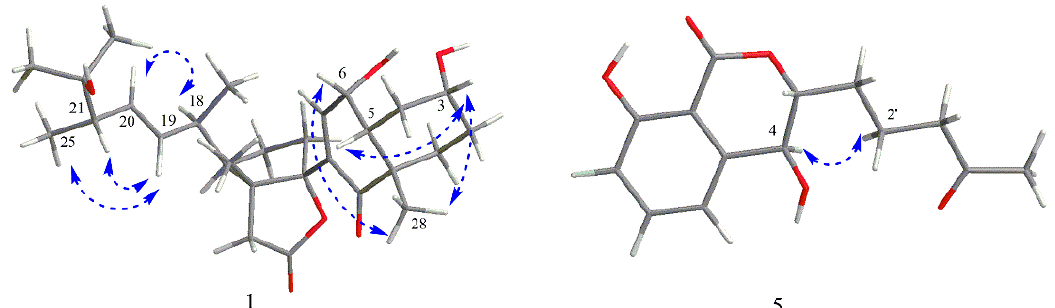
Figure 3. Key partial structures of compounds 1 and 5 from NOESY data.